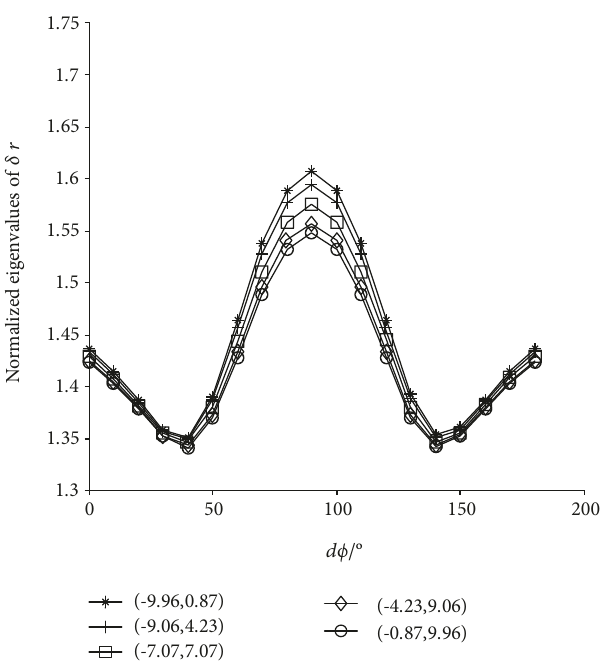
Figure 5: Normalized eigenvalues of the linear distance error between the AUV and the beacon under the fi ve initial